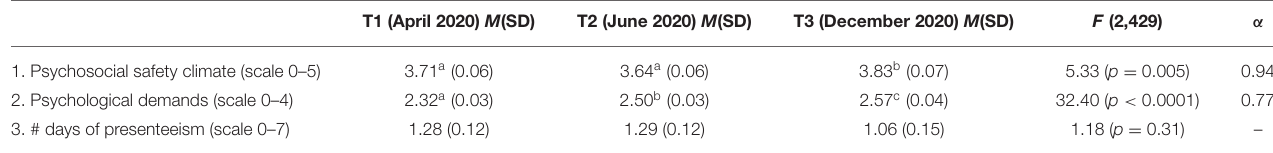
TABLE 3 | Means (M), test of mean differences, SDs, for the study variables (T1, T2, and T3, n = 275), reliability coefficients (Cronbach’s α at